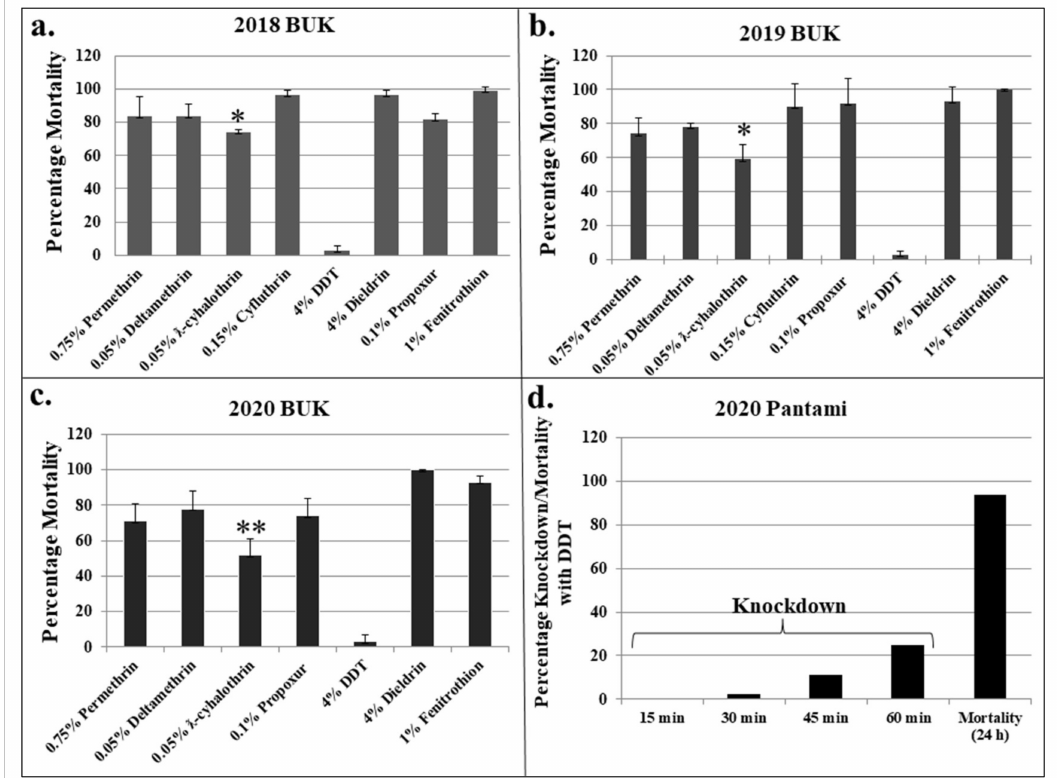
Figure 2. Results of WHO tubes bioassays with different public health insecticides. Results are average of percentage mortalities at 24 h post-exposure, with error bars denoting standard deviation. ( a – c ) indicate result from the BUK population in 2018, 2019 and 2020 respectively, while ( d ) indicates the results of 2020 Pantami population with 4 % DDT. * and ** = mortalities significantly different for ň -cyhalothrin when comparing 2018 vs. 2019 ( p < 0.05) and 2018 vs. 2020 ( p <